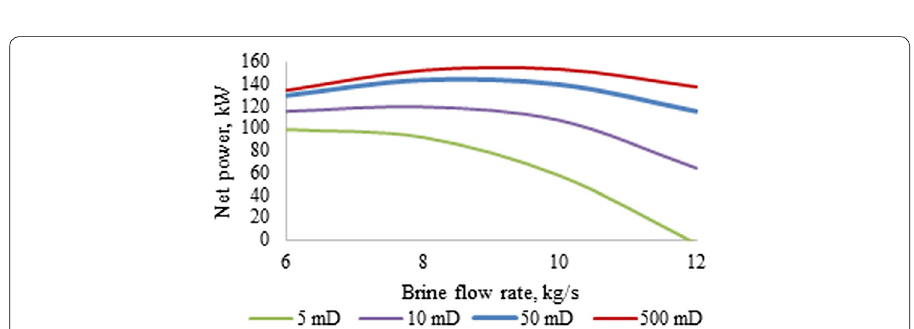
Fig. 18 Net power change with brine flow rate for various reservoir